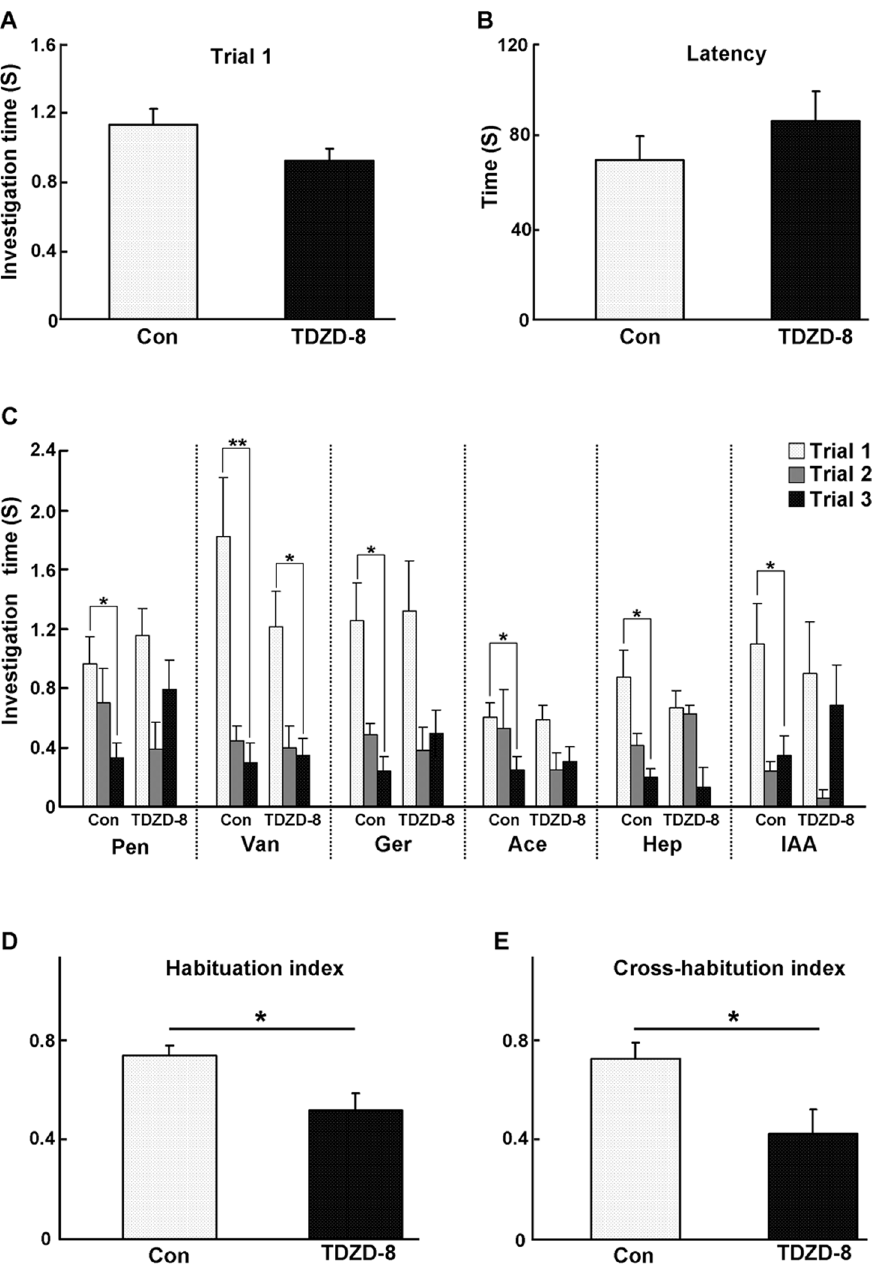
Figure 6. Selective inhibition of GSK3 b activity in the OB impairs odor cross-habituation. A: The investigation time of trial one in each block (each odor) did not show a statistically significant difference between the TDZD-8 and vehicle-treated group (P . 0.05). B: The latencies of each block in the TDZD-8- and vehicle-treated animals were not significantly different (P . 0.05). C: The investigation time of each block and each trial. The TDZD-8 treated group displayed habituation only to vanillin, while the vehicle-treated group habituated to all six of the tested odors. D & E: Compared to the vehicle-treated animals, the habituation index (P , 0.05) and odor cross-habituation index (P , 0.05) in the TDZD-8-treated animals decreased significantly. The data were obtained from 16 animals in the vehicle group and 12 animals in the TDZD-8 group. * P , 0.05, ** P , 0.01. The group data shown are the average 6 SEM.